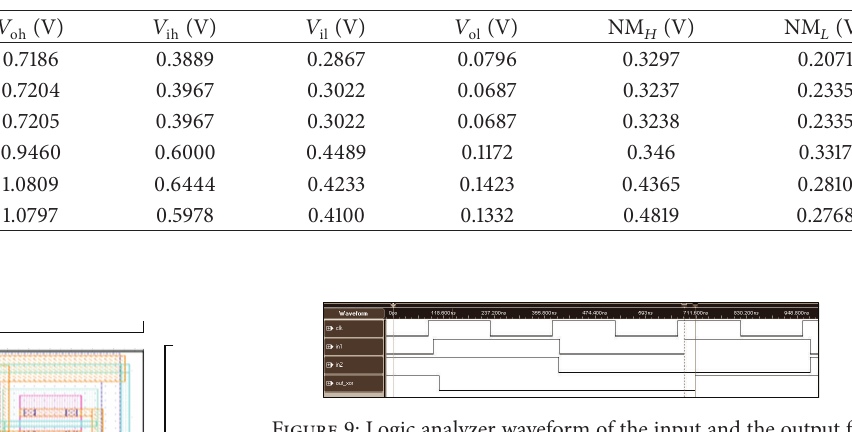
Table 2: Comparison of noise margins of different CMOS XOR gates with the proposed XOR gate.